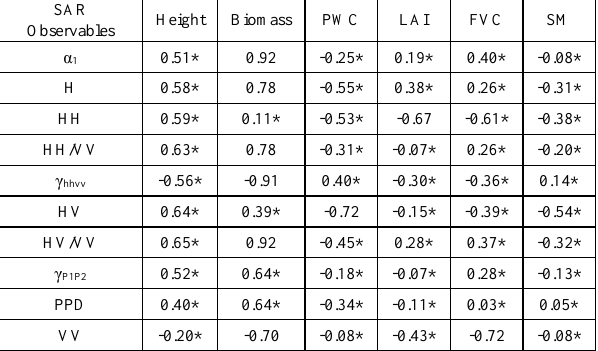
Table 8. Correlation (R Pearson) between SAR observables and field estimations for N9 (rye). Non-significant correlations at 95% confidence level are indicated by